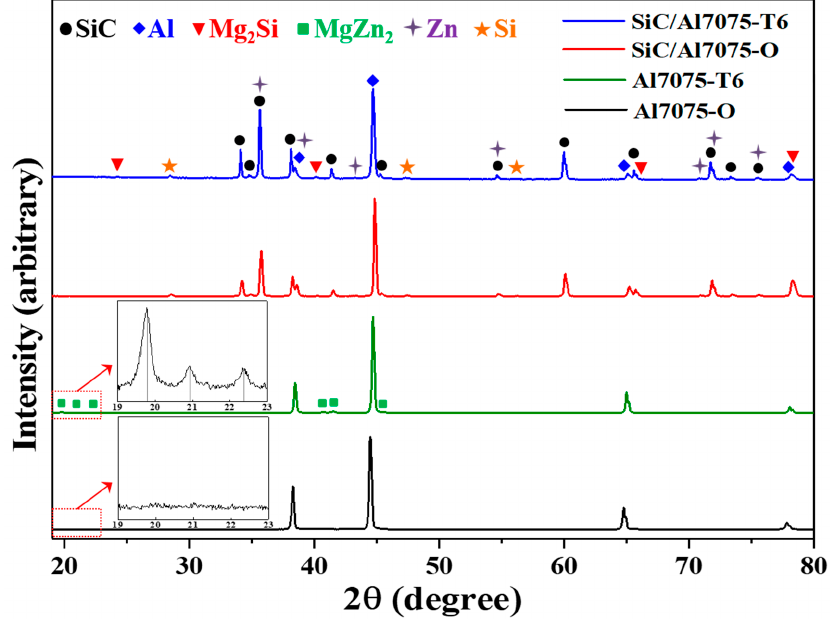
Figure 3. The X-ray diffraction pattern of the BS31 composite and Al7075 matrix after annealing or T6 ◦ –23 ◦ heat treatment (insets: enlargement of the 19°–23° region). heat treatment (insets: enlargement of the 19